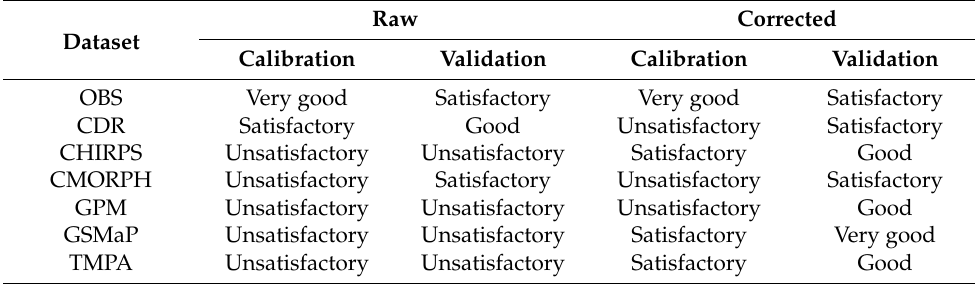
Table 3. Hydrological model performance under different input